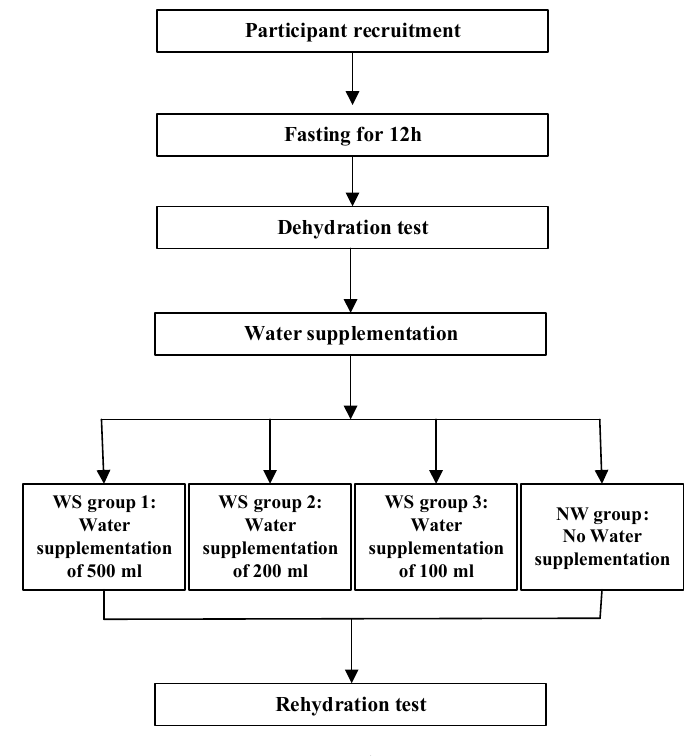
Figure 1. Study Design.